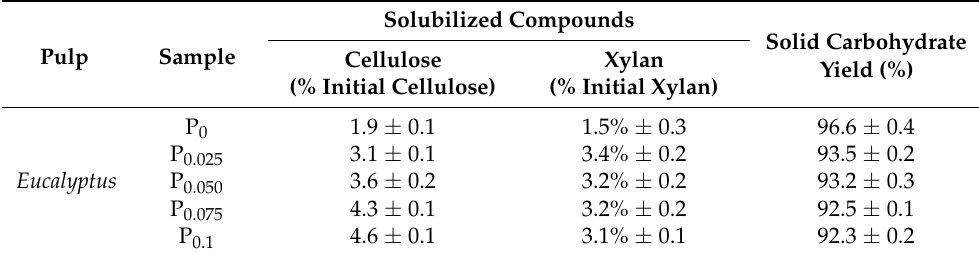
Table 1. Enzymatic hydrolysis and solubilization of carbohydrates.